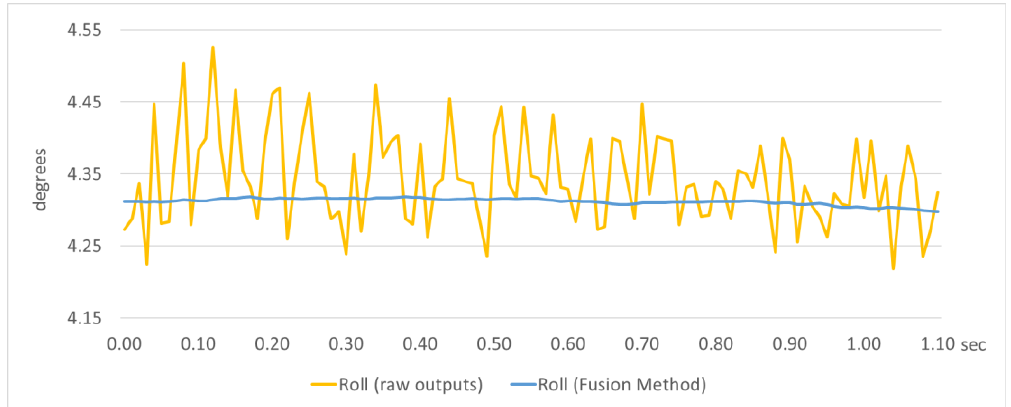
Figure 7. Roll angle estimation by raw outputs and the fusion method in static condition.